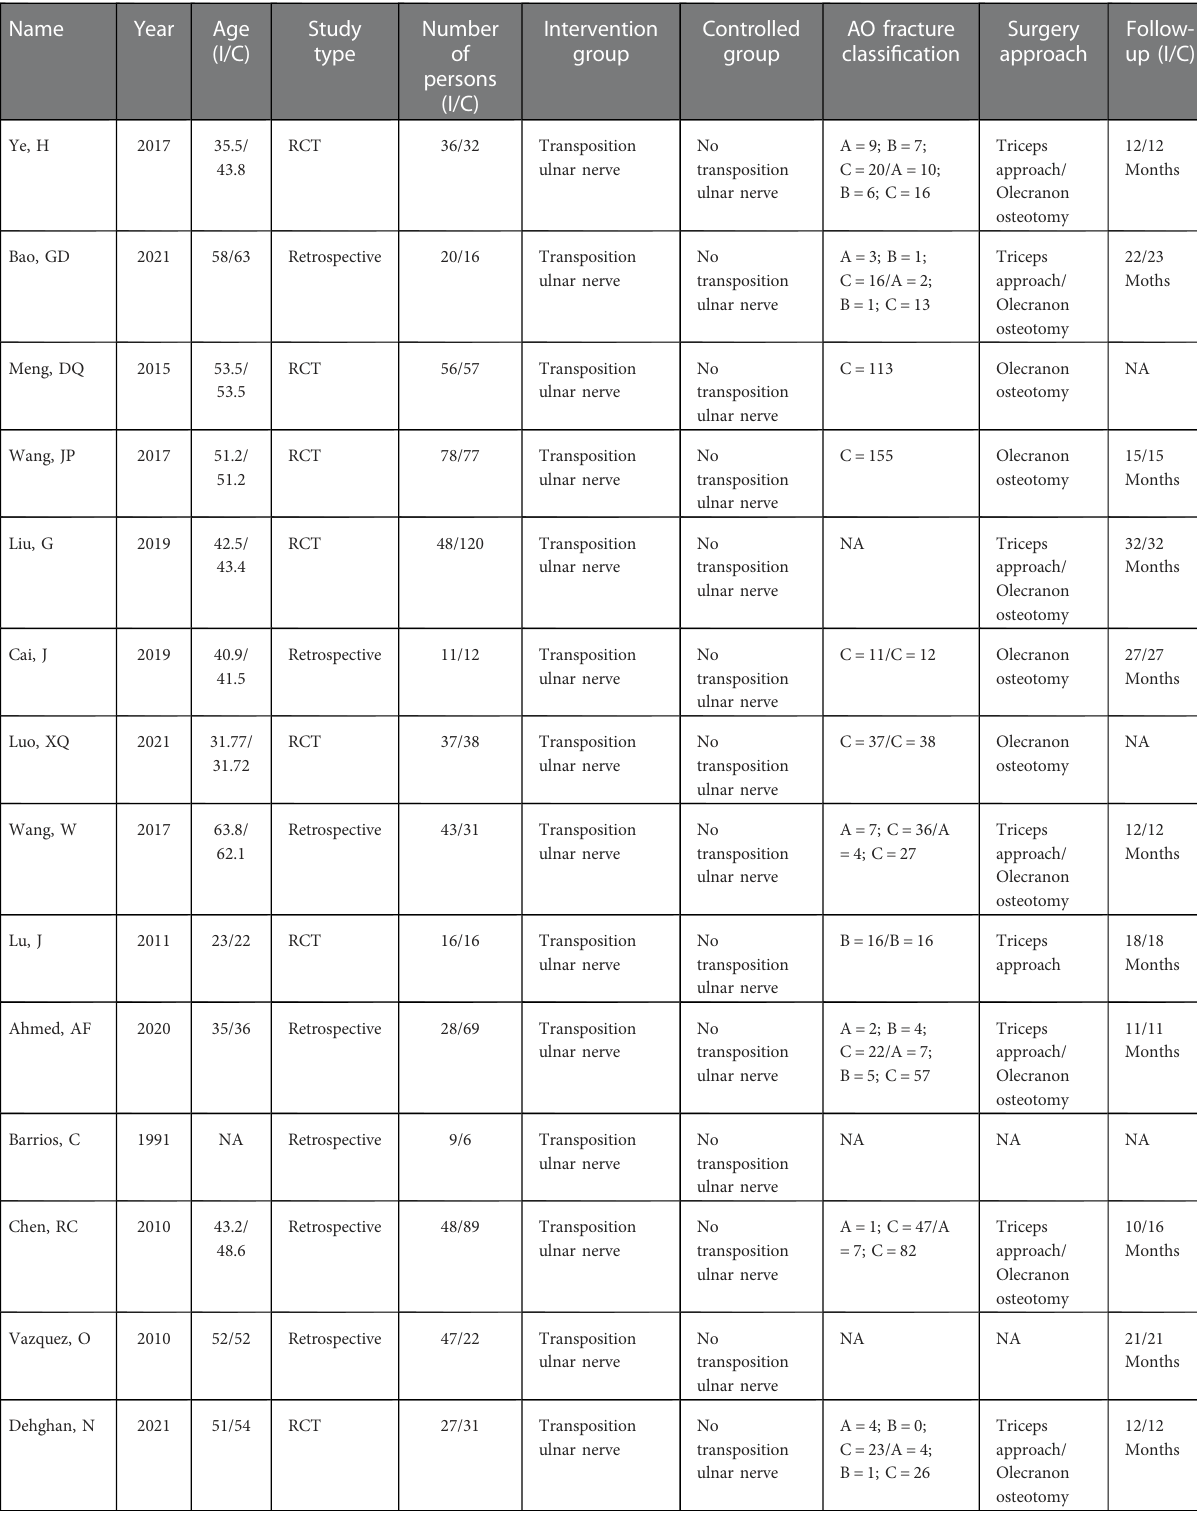
TABLE 1 Basic characteristics of the included